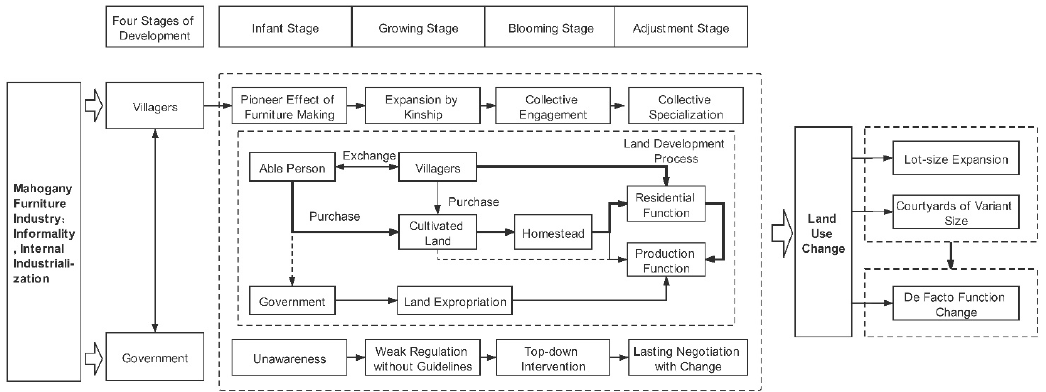
Figure 6. A framework of the land development process in Fengzhuang under the influence of informality, internal industrialization, and government regularization.